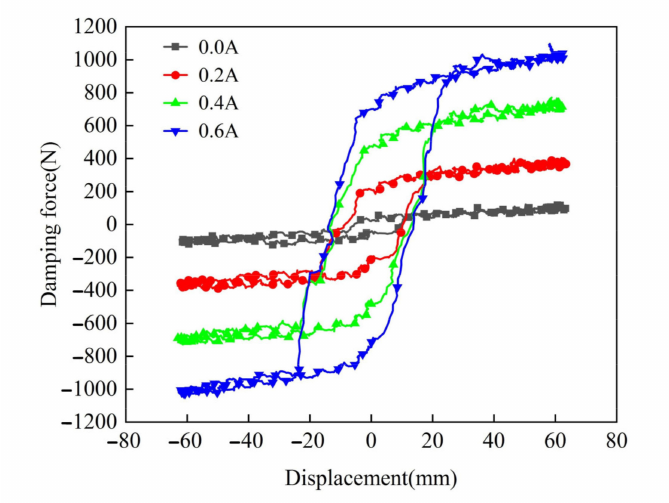
Figure 17. Relationship of force and velocity under different current experimental